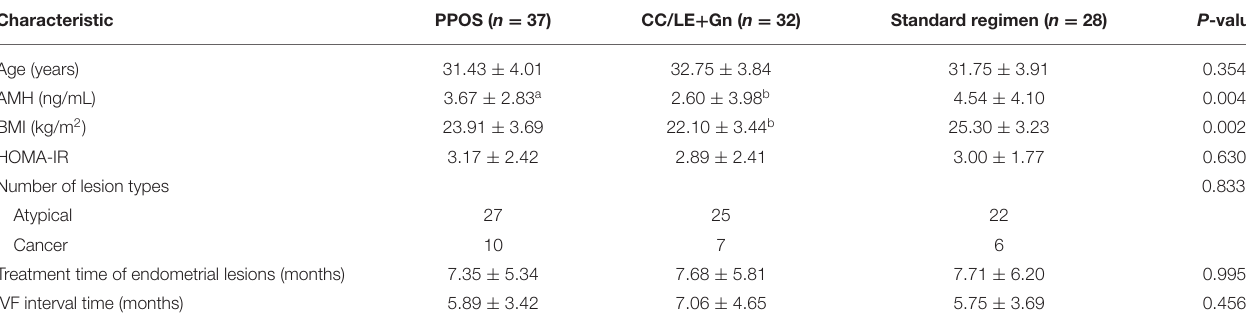
TABLE 1 | Baseline characteristics of patient in different ovulation stimulation regimens.